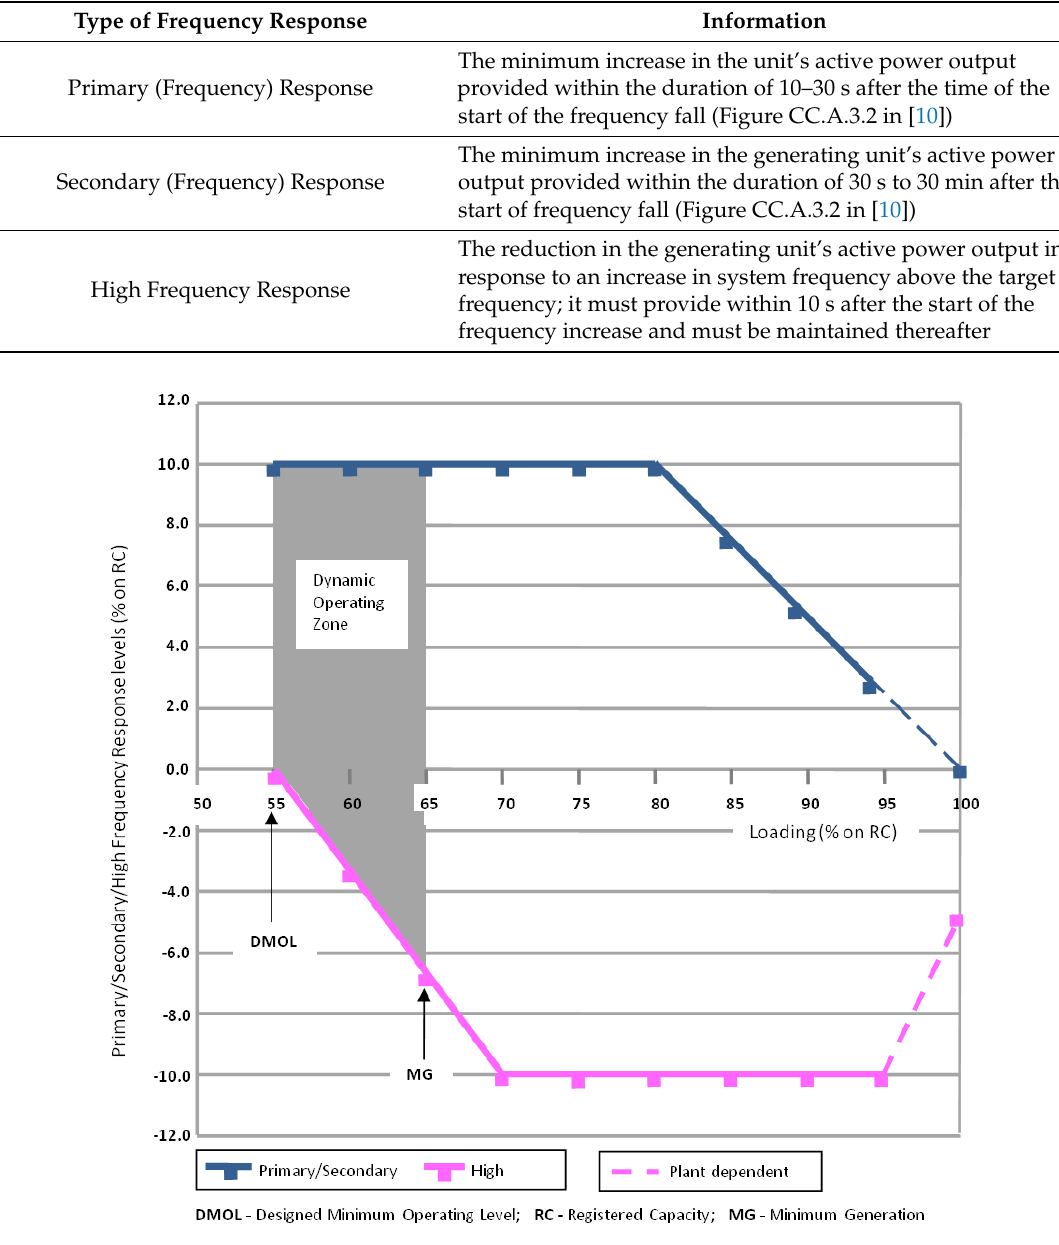
Figure 3. The minimum frequency response requirement profile for a 0.5 Hz frequency changing in the GB grid from target frequency